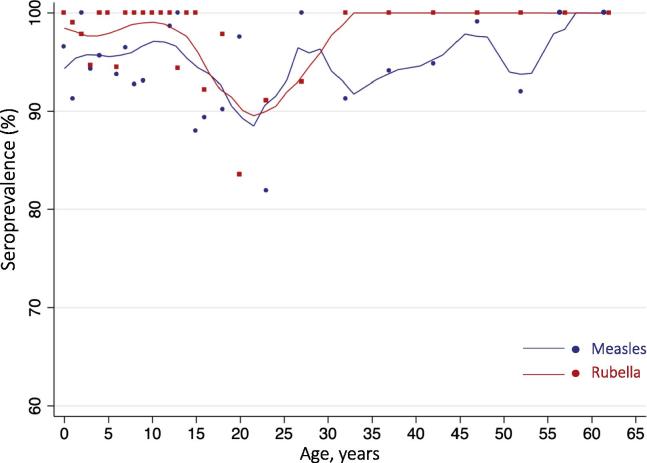
Age-specific measles and rubella seroprevalence among serosurvey participants in Southern Province, Zambia (n = 590).Notes: Age-specific measles and rubella IgG seroprevalence in blue and red, respectively. Dots (•) represent seroprevalence point estimates for each age group using age bins with approximately equal sample size, one year intervals for ages 9 months to 15 years, two year intervals for ages 16–19 years, five year intervals for ages 20–65 years. Lines are smoothed seroprevalence estimates using kernel-weighted local polynomial regression. Equivocal results were classified as positive. (For interpretation of the references to colour in this figure legend, the reader is referred to the web version of this article.)